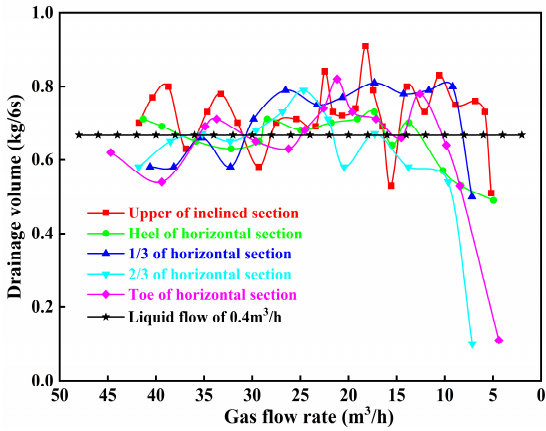
Figure 3. Drainage stability of different tubing depth.